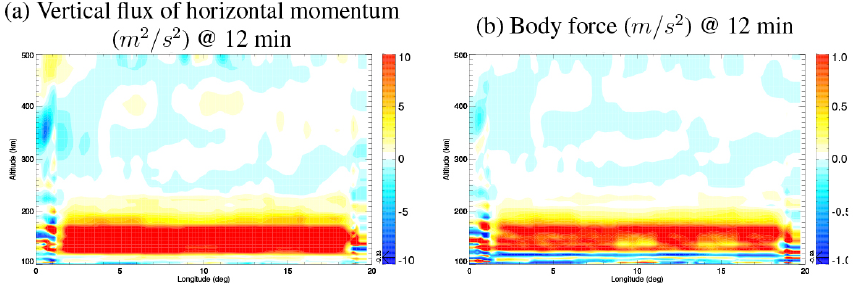
Fig. 3. Vertical flux of horizontal momentum (a) and body force (b) at